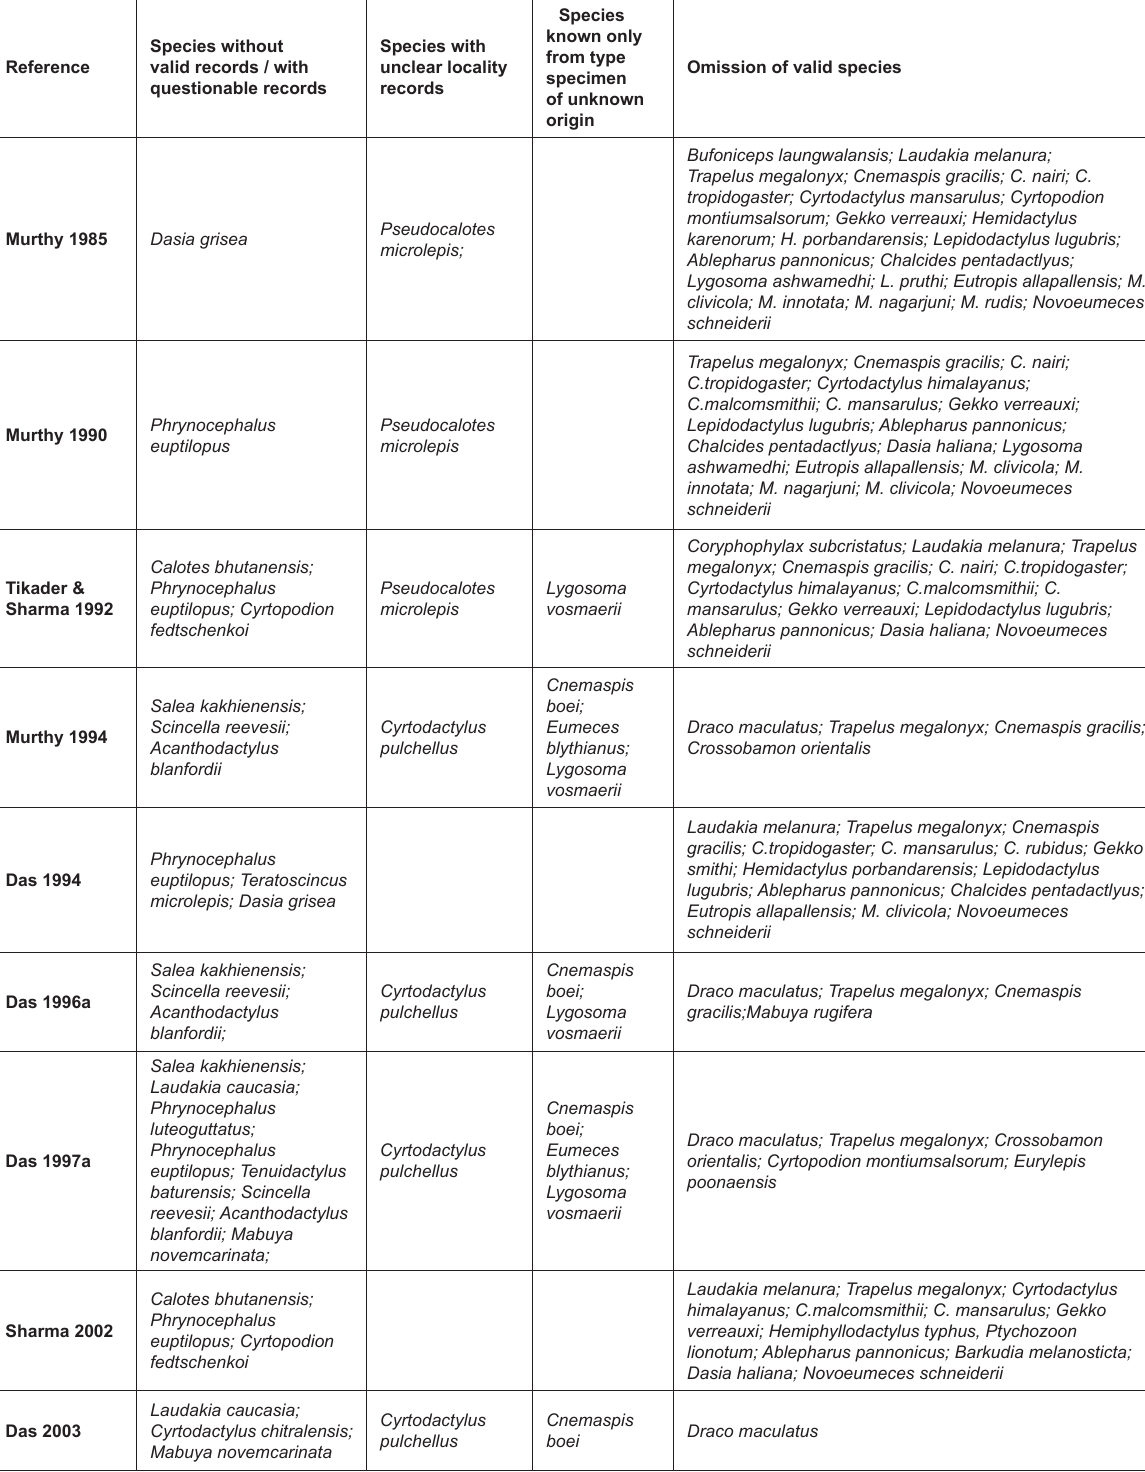
Table 3. Erroneous inclusion and omission of species in the checklists of Indian reptiles. The references have been arranged